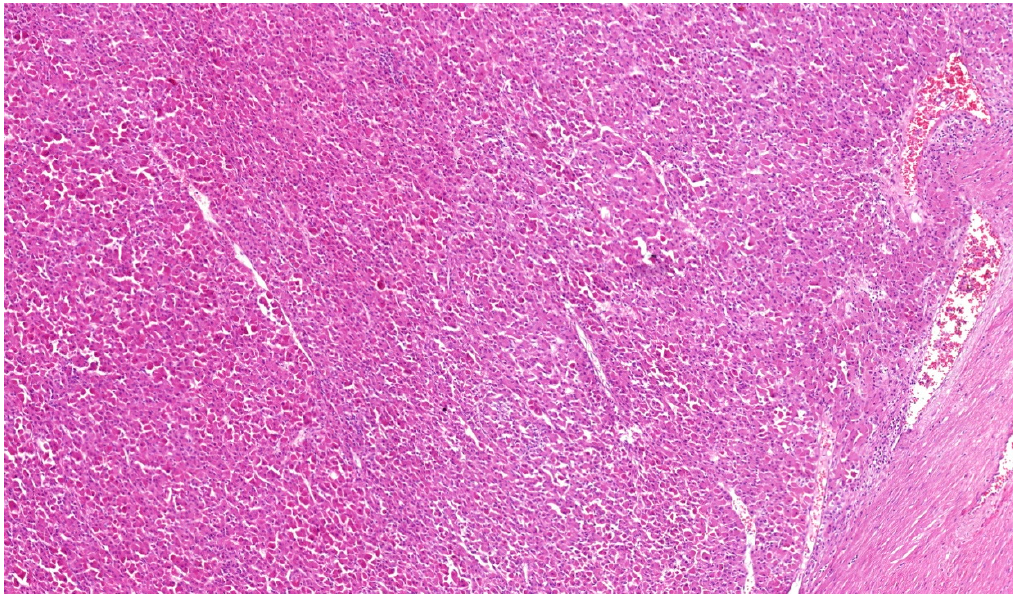
Figure 1. Some renal cell carcinomas (RCCs) with TFEB translocation lack typical morphology with pseudorosettes and rather show solid architecture. 4× magnification.